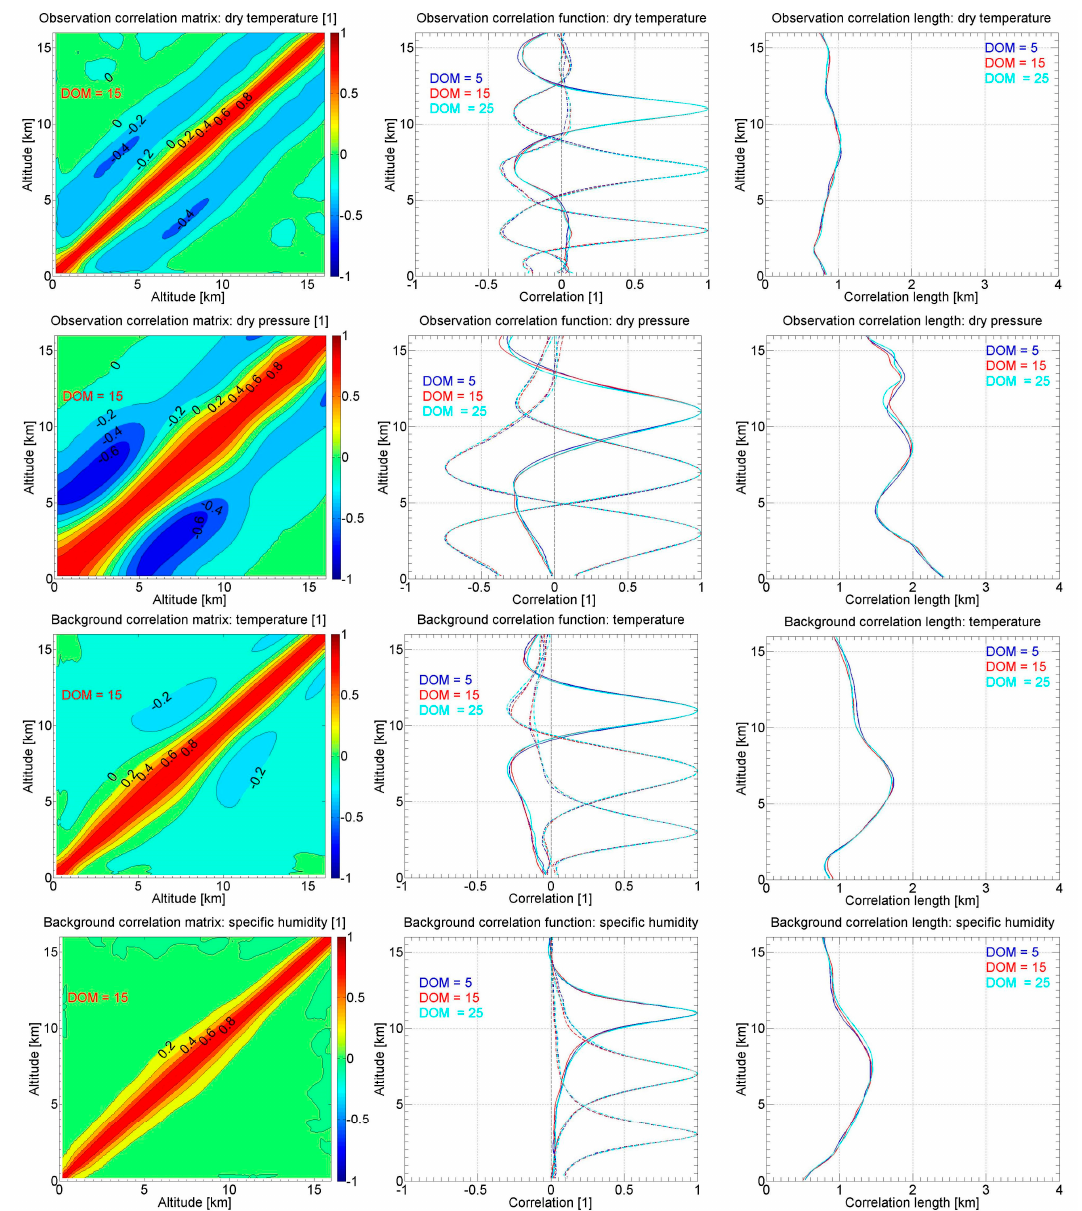
Figure A3. Correlation matrices (left), exemplary correlation functions at three exemplary altitude levels of 11 km, 7 km, and 3 km (middle), and estimated correlation length for correlation functions (right) for the observed dry temperature uncertainty (first row), observed dry pressure uncertainty (second row), background temperature uncertainty (third row), and background specific humidity uncertainty (fourth row). The correlation matrices are shown for 15th July 2008 only, and the correlation functions and correlation lengths are shown for 5th, 15th, and 25th of July 2008.